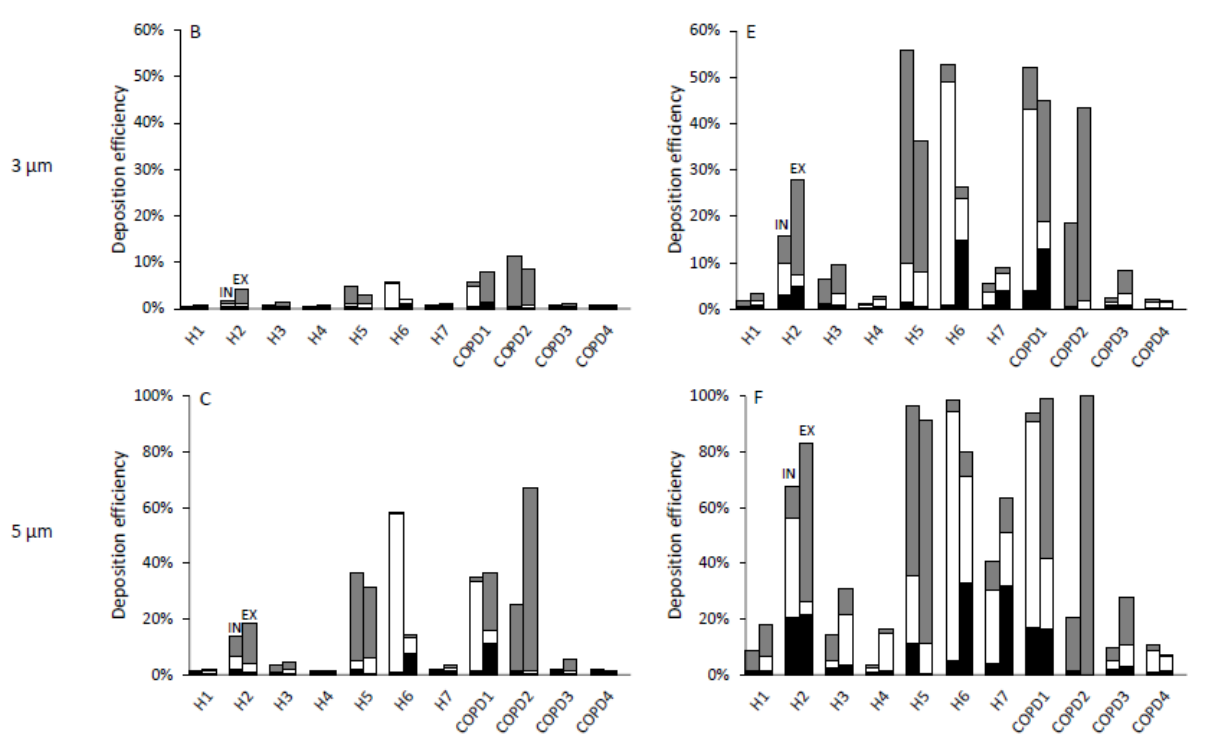
Figure 5. Comparison of deposition occurring during inhalation (IN) and exhalation (EX) in the different subregions of the oral airway. Deposition for 1, 3 and 5 µ m particles are shown in top ( A , D ),